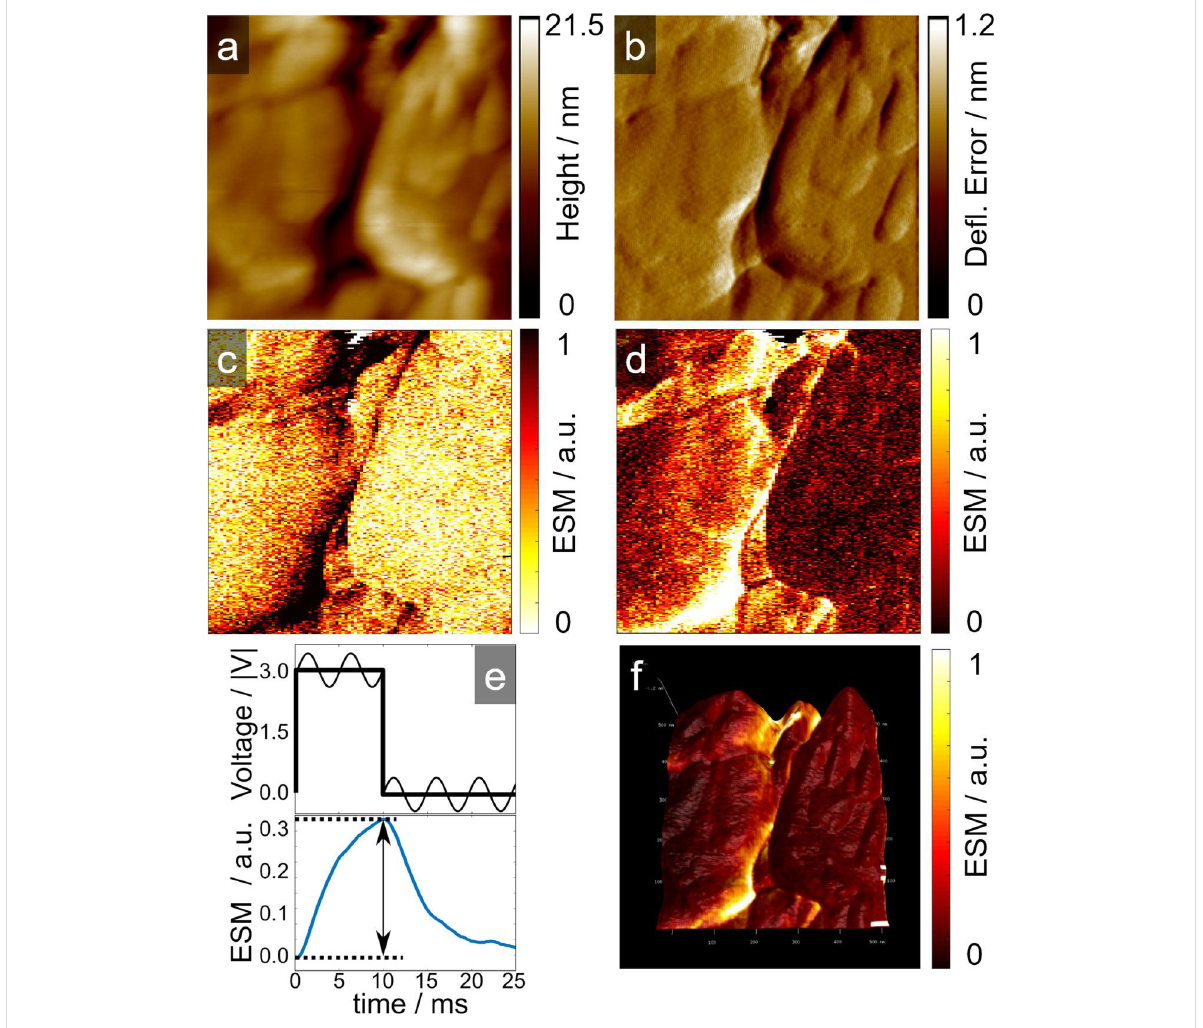
Figure 2: Topography (a), deflection error (b) and ESM amplitude due to the positive and negative voltage pulse (c and d) at the fresh cathode. In e), an example of the measured ESM signal with the applied voltage pulse are shown. In f) is the result from d) overlaid on the topography in a). Scan size is 1 × 1 µm 2